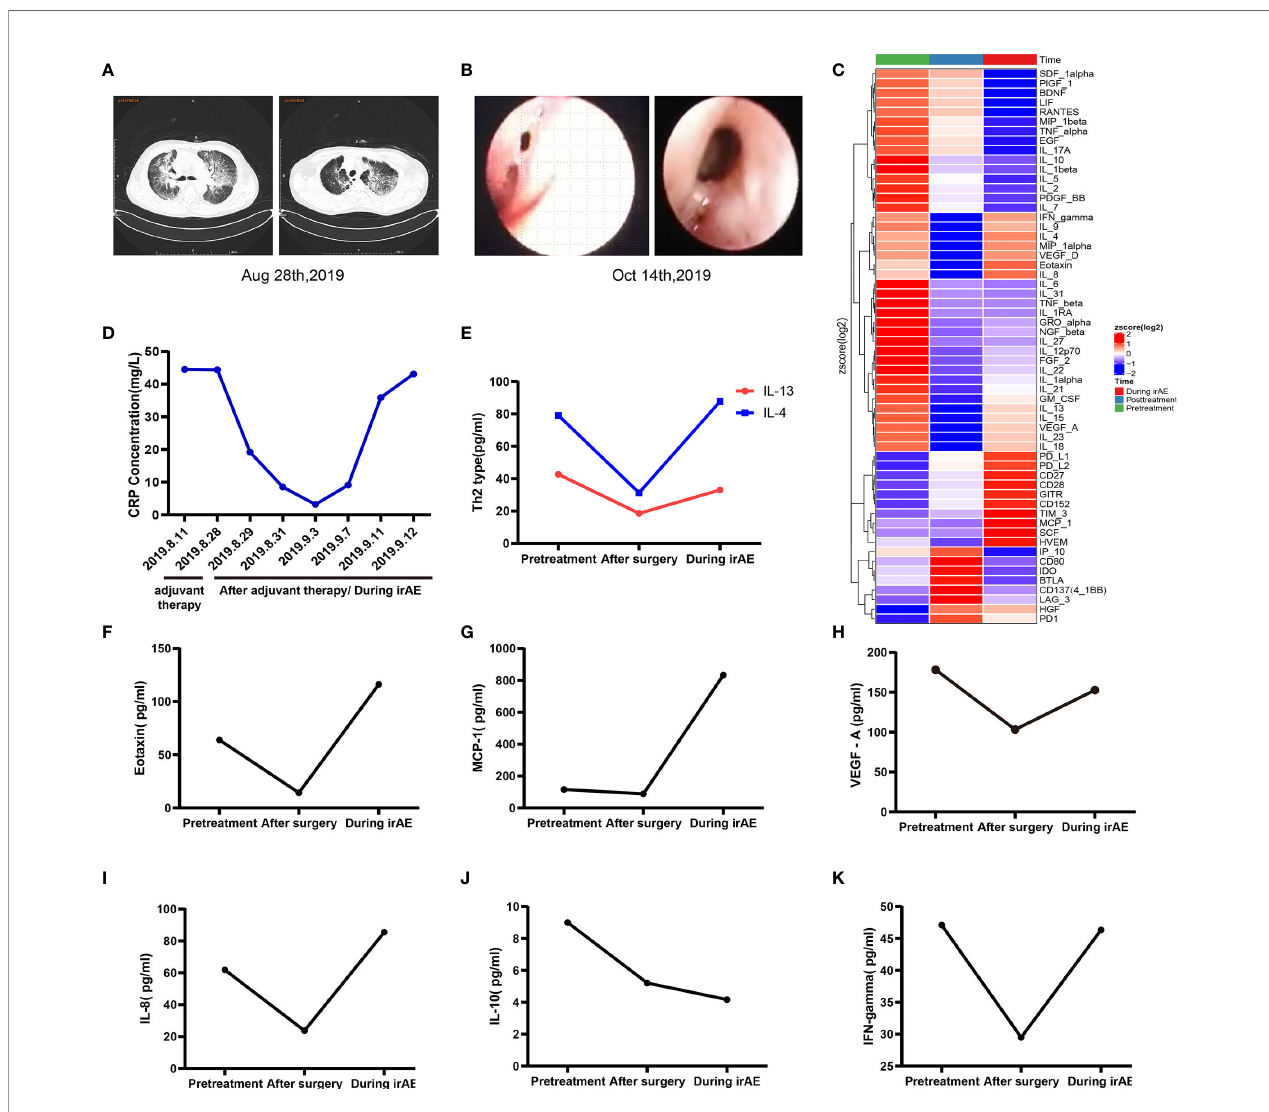
FIGURE 4 | Changes in related indexes during adjuvant immunochemotherapy and irAEs. (A) Pulmonary CTA indicated multiple cords, plaques, and fl occulent high- density shadows in both lungs, bilateral pleural effusion, and a clinical diagnosis of immune-associated pneumonia (CTCAE level 4). (B) Bronchoscopy revealed a fi stula at the anastomosis of the right bronchus and the formation of a bloody abscess cavity. (C) Multiplexed bead immunoassay results during the entire treatment period. (D) Representative CRP levels during adjuvant immunochemotherapy and irAEs. (E – K) Representative multiplexed bead immunoassay results during the entire treatment